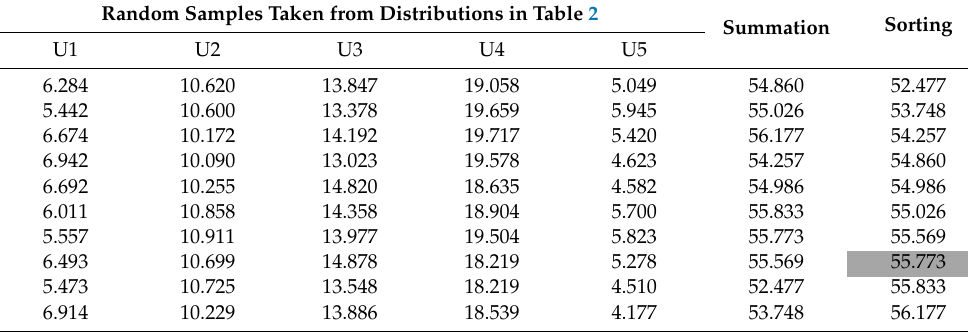
Table 3. Result of Monte Carlo Simulation for the given example (The highlighted cell is travel time of the path at confidence interval